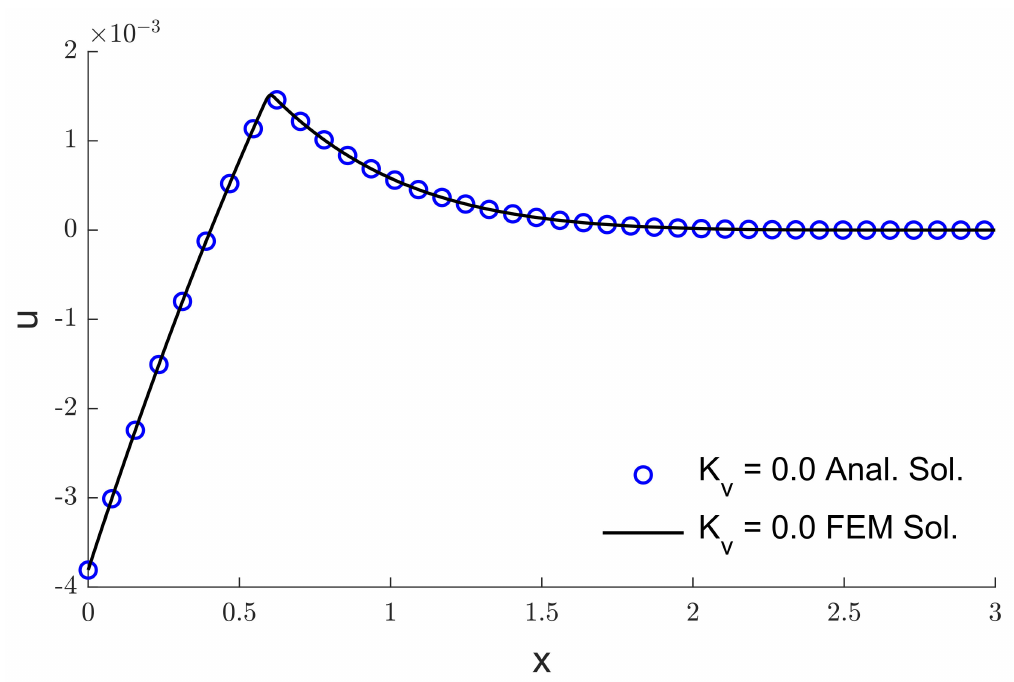
Figure 11. The displacement variation with and without Kirchhoff transform when K v =